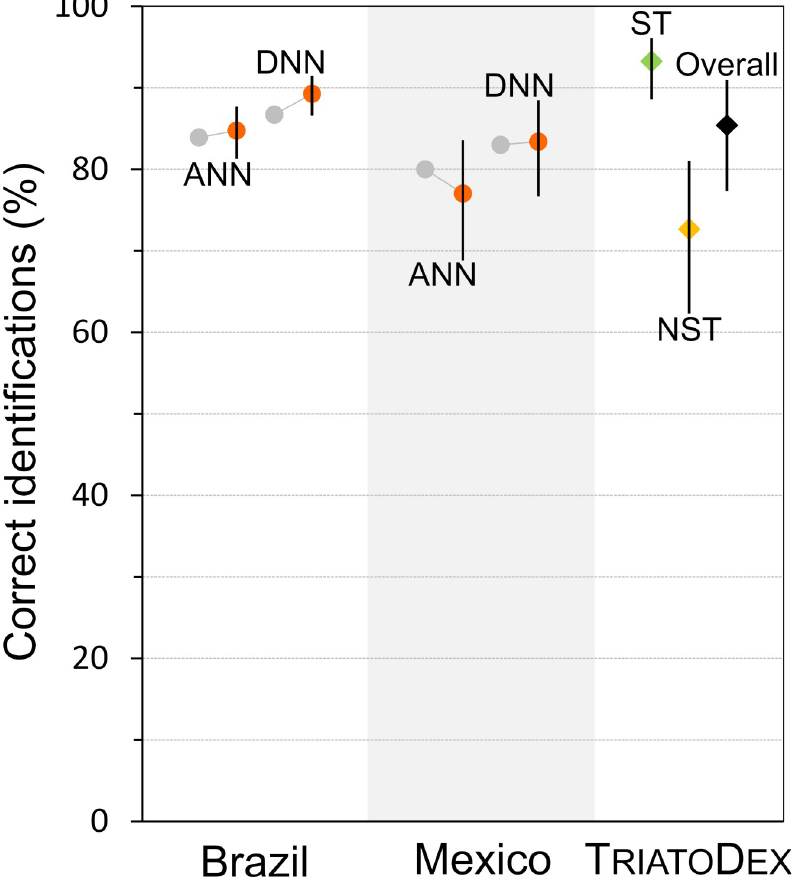
Fig 4. T RIATO D EX performance: A comparison with neural network-based models used in automated triatomine- bug identification [35,57]. We used data provided in [57] and present them either as reported (grey circles) or after a reanalysis based on generalized linear mixed models (red circles) similar to the ones we used to assess T RIATO D EX performance (diamonds). The data in [57] refer to Brazilian and Mexican triatomines identified using either artificial neural networks (ANN, [35]) or deep neural networks (DNN, [57]). T RIATO D EX results refer to the top-ranking model in our analyses (S2 Table), which distinguishes users with specialized training in triatomine-bug taxonomy (ST, green diamond) from those without (NST, orange diamond); the last value (Overall, black diamond) refers to a ‘null’ model without fixed-effect covariates. Error bars are 95% confidence intervals; note that the ‘success rates’ reported in [57] (grey circles) lack any measure of uncertainty. The values are given as percentages to match [35,57].